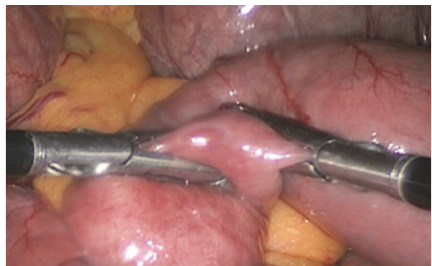
Figure 2: Gentle laparoscopic manipulation and